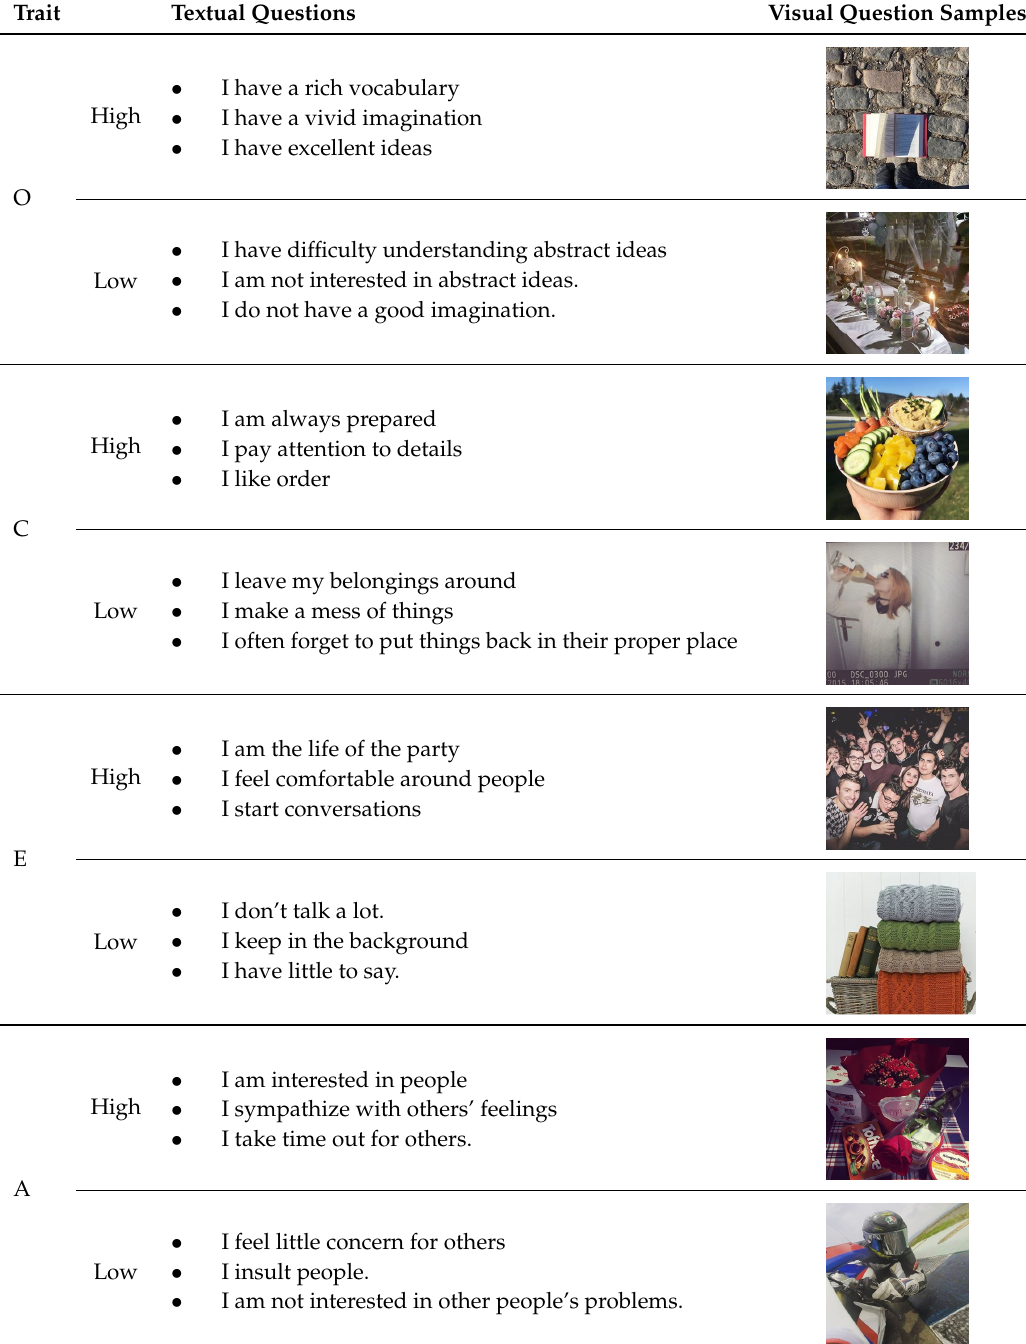
Table 2. Sample of the images and questions used to assess users’ personality. None of these images were used for CNN